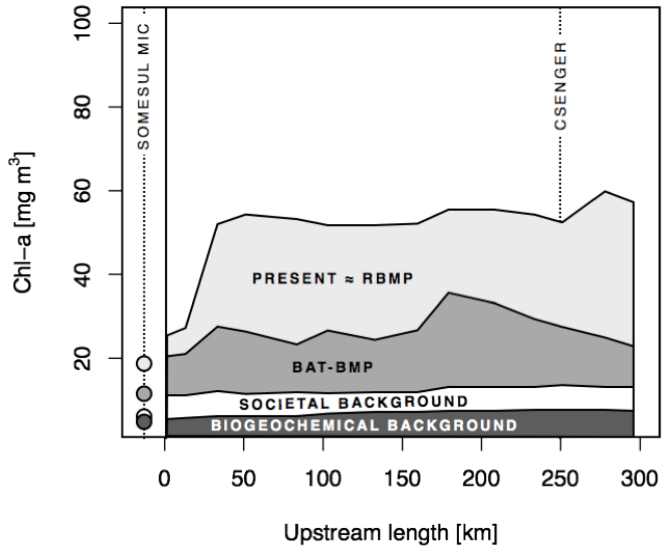
Figure 5. Longitudinal algal profiles along the Szamos River in different